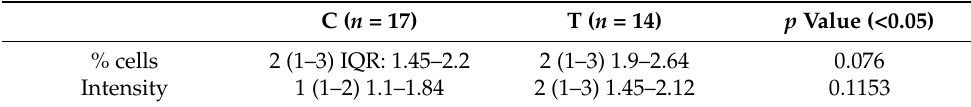
Figure 3. Immunohistochemistry scores to evaluate COX-2 expression. Score 1 ( A ): multifocal and moderate positivity (pink stain) around the granulomas; score 2 ( B ): multifocal and moderate positivity around the granulomas and in interstitial tissue; score 3 ( C ): diffuse and strong positivity around the granuloma and in the interstitial tissue. Magnification 10 × . No statistically significant differences were highlighted between the groups (Table 2). Table 2. Expression of COX-2 and intensity of the positivity.